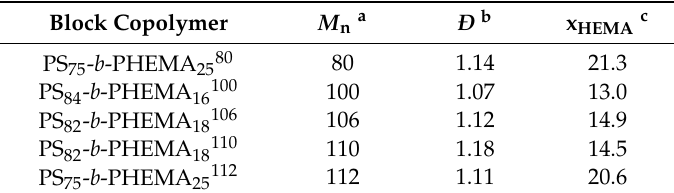
Table 1. Characterization of synthesized block copolymers PS– b –PHEMA obtained by SEC measurements and 1 H NMR spectroscopy.